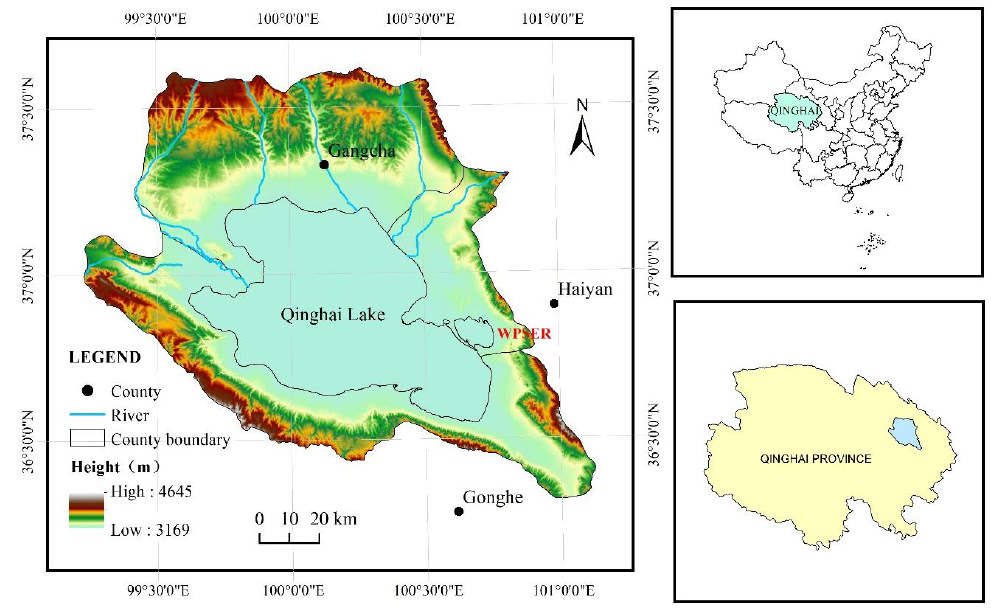
Figure 1. Geographic location of the study area.